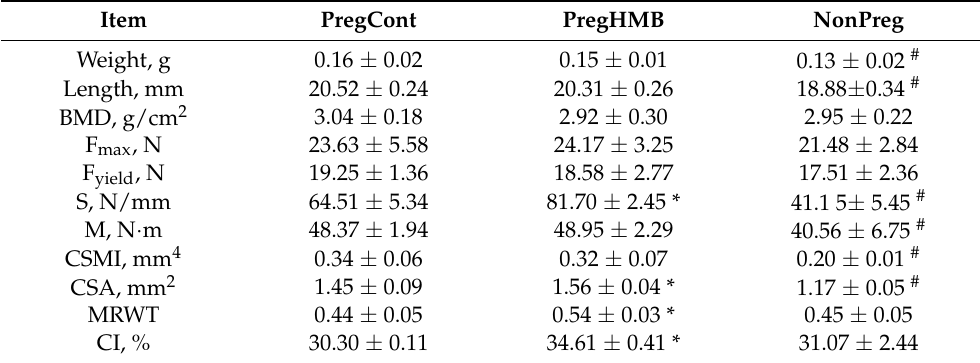
Table 1. Osteometric, mechanical, and densitometric parameters of femora from pregnant (control and supplemented with β -Hydroxy β -methylbutyrate (HMB)) and non-pregnant female spiny mice. Item PregCont PregHMB NonPreg Weight, g